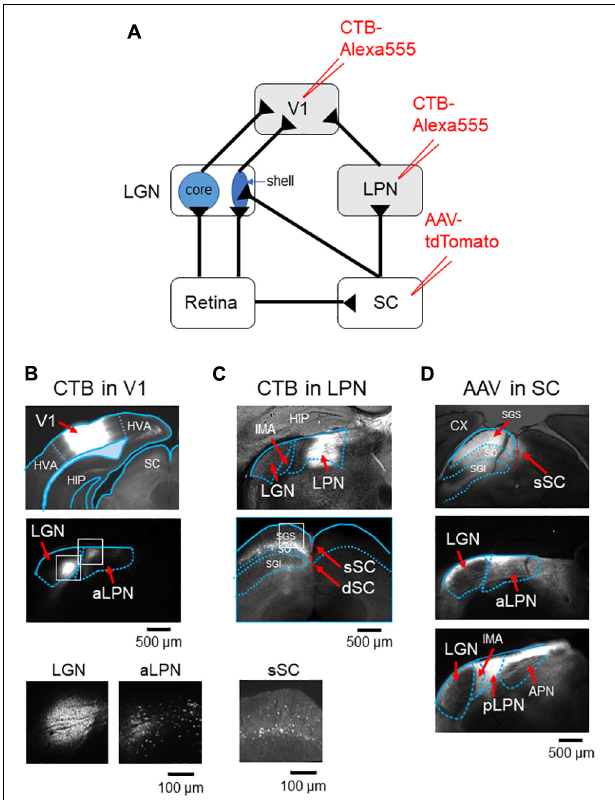
FIGURE 1 | V1 receives inputs from both the LGN and LPN. (A) A retrograde labeling by CTB injection into either V1 or LPN. (B) CTB was injected into V1 (upper), both the LGN and LPN were retrogradely labeled (middle), and the retrogradely labeled neurons were observed (lower, enlargement of the white rectangles in the middle). (C) CTB was injected into the anterior part of the LPN (upper), SC was retrogradely labeled (middle), and the retrogradely labeled neurons were observed (lower, enlargement of the white rectangle in the middle). (D) AAV-tdTomato was injected into SC (upper) and both the aLPN (middle) and pLPN (lower) were innervated by SC neurons. Note that the shell of the LGN also received SC inputs (middle). LGN, lateral geniculate nucleus; LPN, lateral posterior nucleus; aLPN, anterior part of LPN; pLPN, posterior part of LPN; CX, cortex; HIP, hippocampus; CTB, cholera toxin subunit B; V1, primary visual cortex; SGS, upper stratum griseum superficial; SO, stratum opticum; SGI, stratum griseum intermedium; sSC, superficial layers of the superior colliculus; dSC, deep layers of the superior colliculus; APN, anterior pretectal nucleus; IMA, intramedullary thalamic